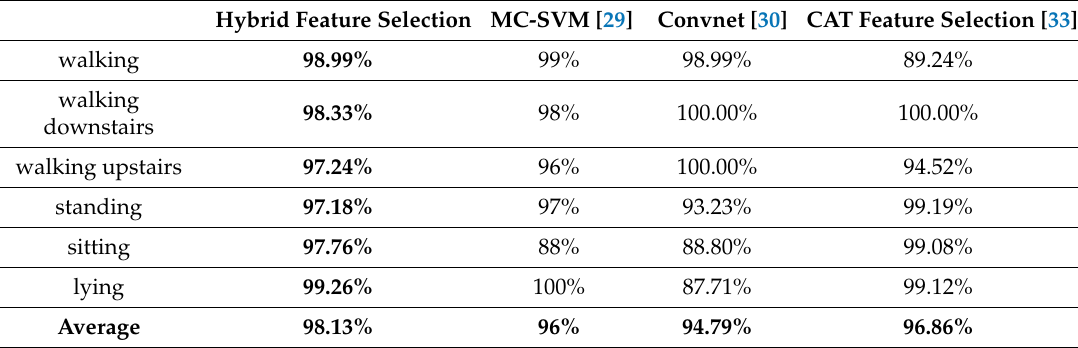
Table 6. Classification accuracies of di ff erent feature selection